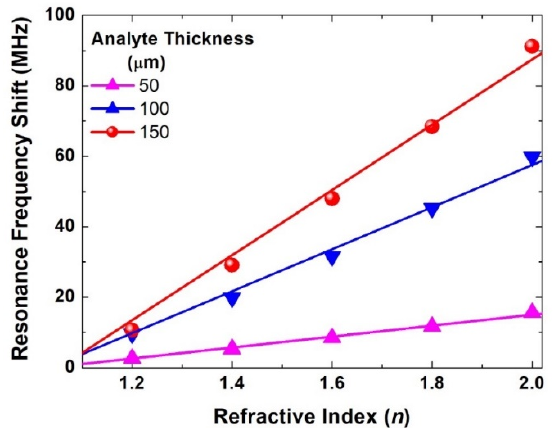
Figure 6. Resonance frequency shift in MHz versus the refractive index ( n ) of the overlayer analyte with different thicknesses between 50 and 150 m.